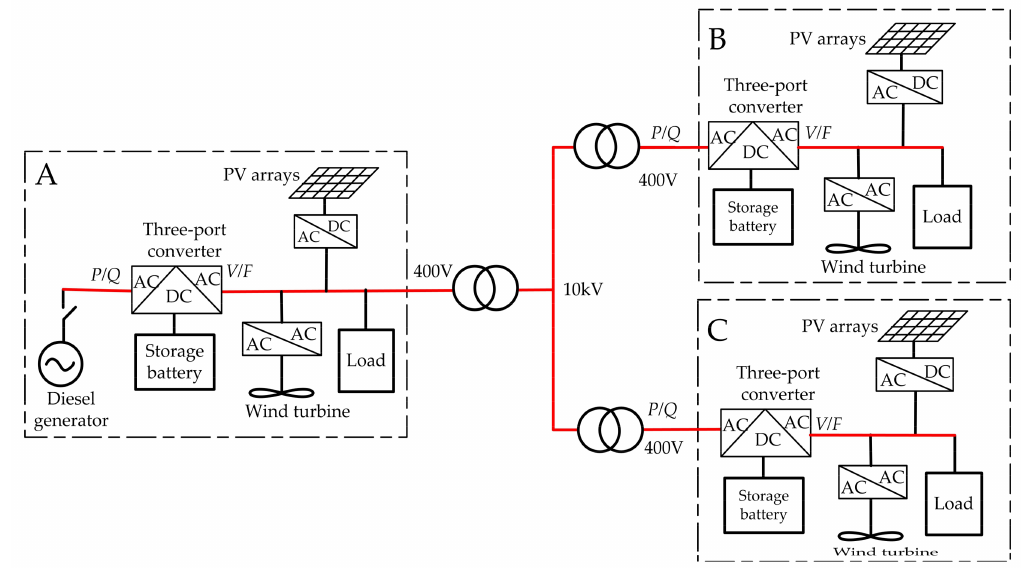
Figure 2. Structure of the modular microgrid on DongAo